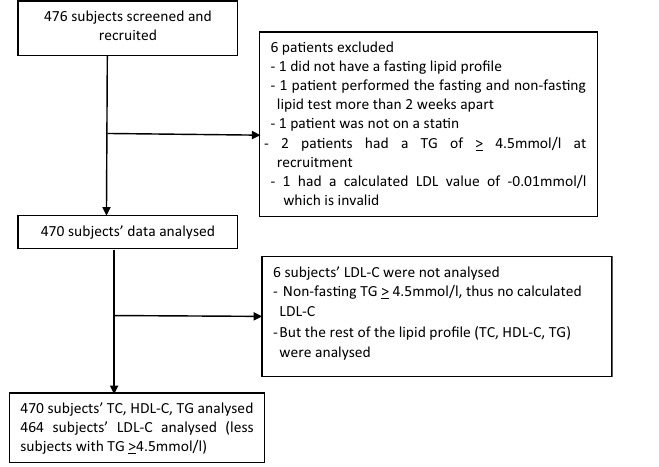
Figure 1. Consort flow